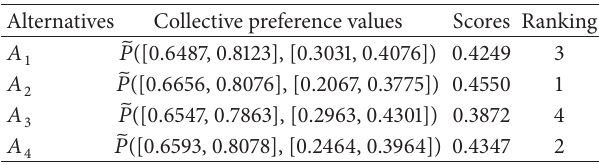
Table 3: The collective preference values, scores, and ranking of alternatives.